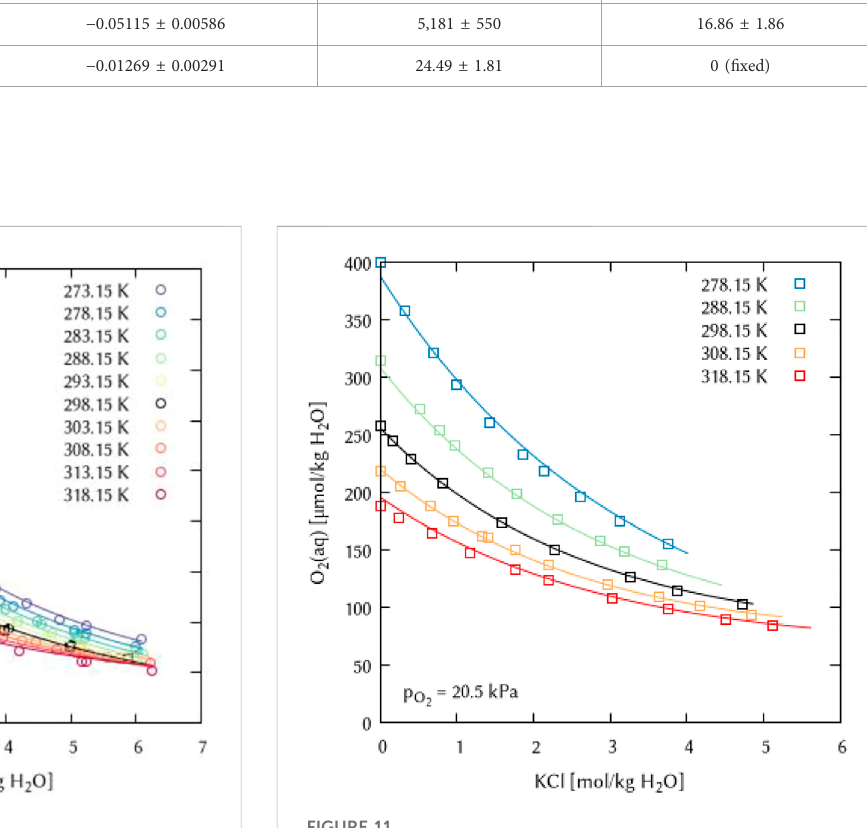
FIGURE 10 Modelling of the O 2 solubility in sodium chloride solution as a function of temperature and NaCl concentration. (Points: Experimentaldatafrom □ Milleroetal.(2002a), ○ Milleroetal.(2002b), n Millero et al. (2003), Lines: this work).